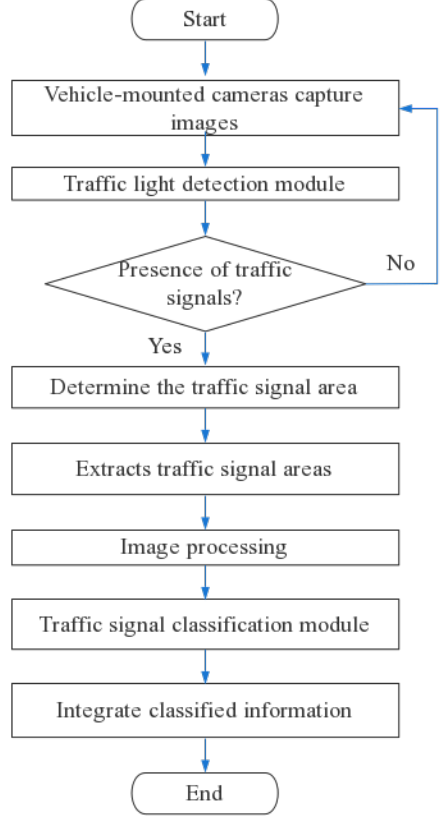
Figure 2. Traffic light detection and recognition flow